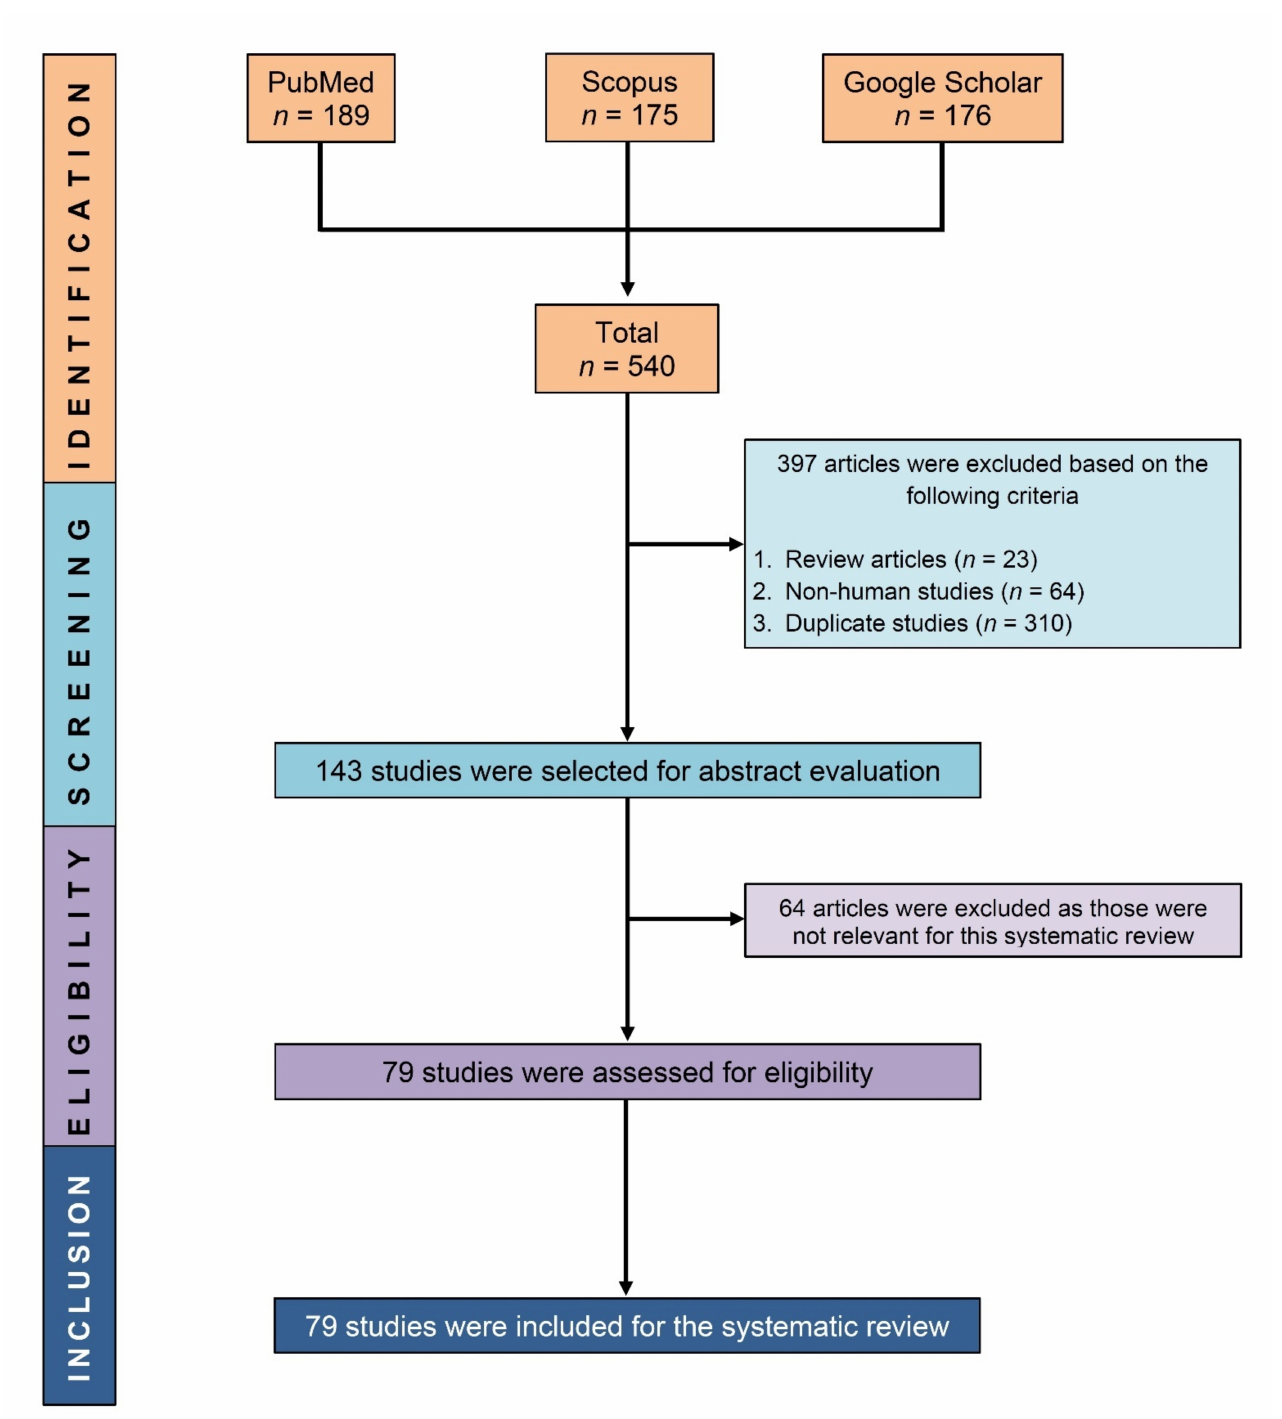
Figure 1. PRISMA flow diagram showing the process of selecting eligible